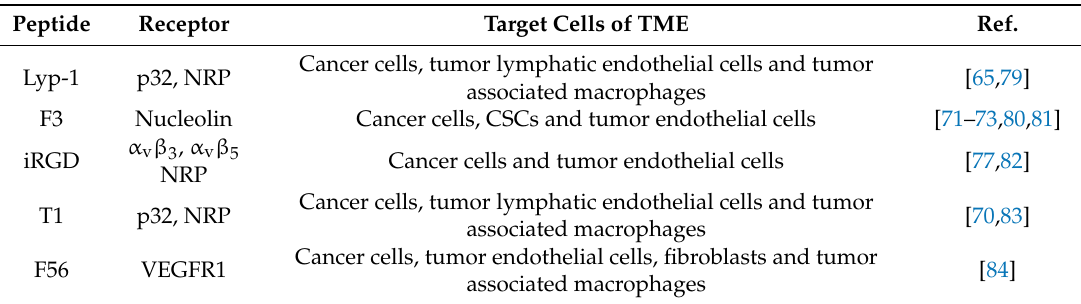
Table 1. Examples of peptides for simultaneous